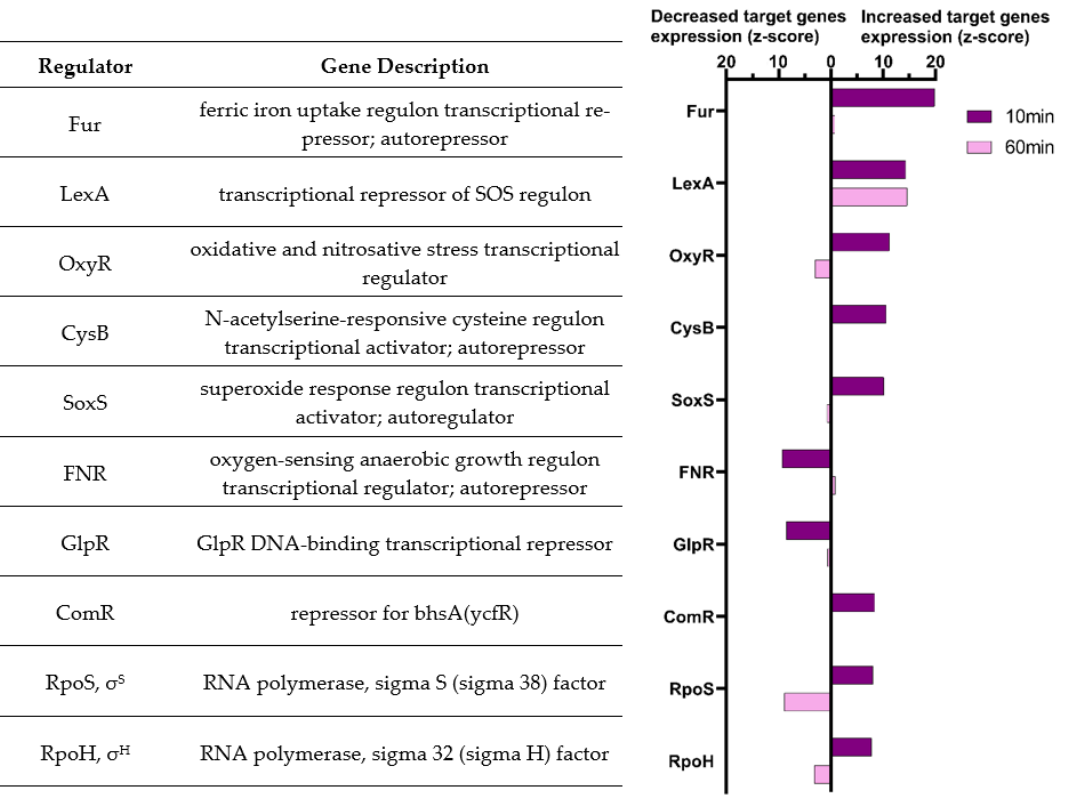
Figure 4. The top 10 most significant regulators implicated in gene expression changes 10 min after H 2 O 2 exposure, using ISMARA. The significance (z-score) is illustrated for the two time points, 10 min (dark purple) and 60 min (light purple); bars extend to the left if target genes are down-regulated or to the right if they are up-regulated in the H 2 O 2 -exposed condition.